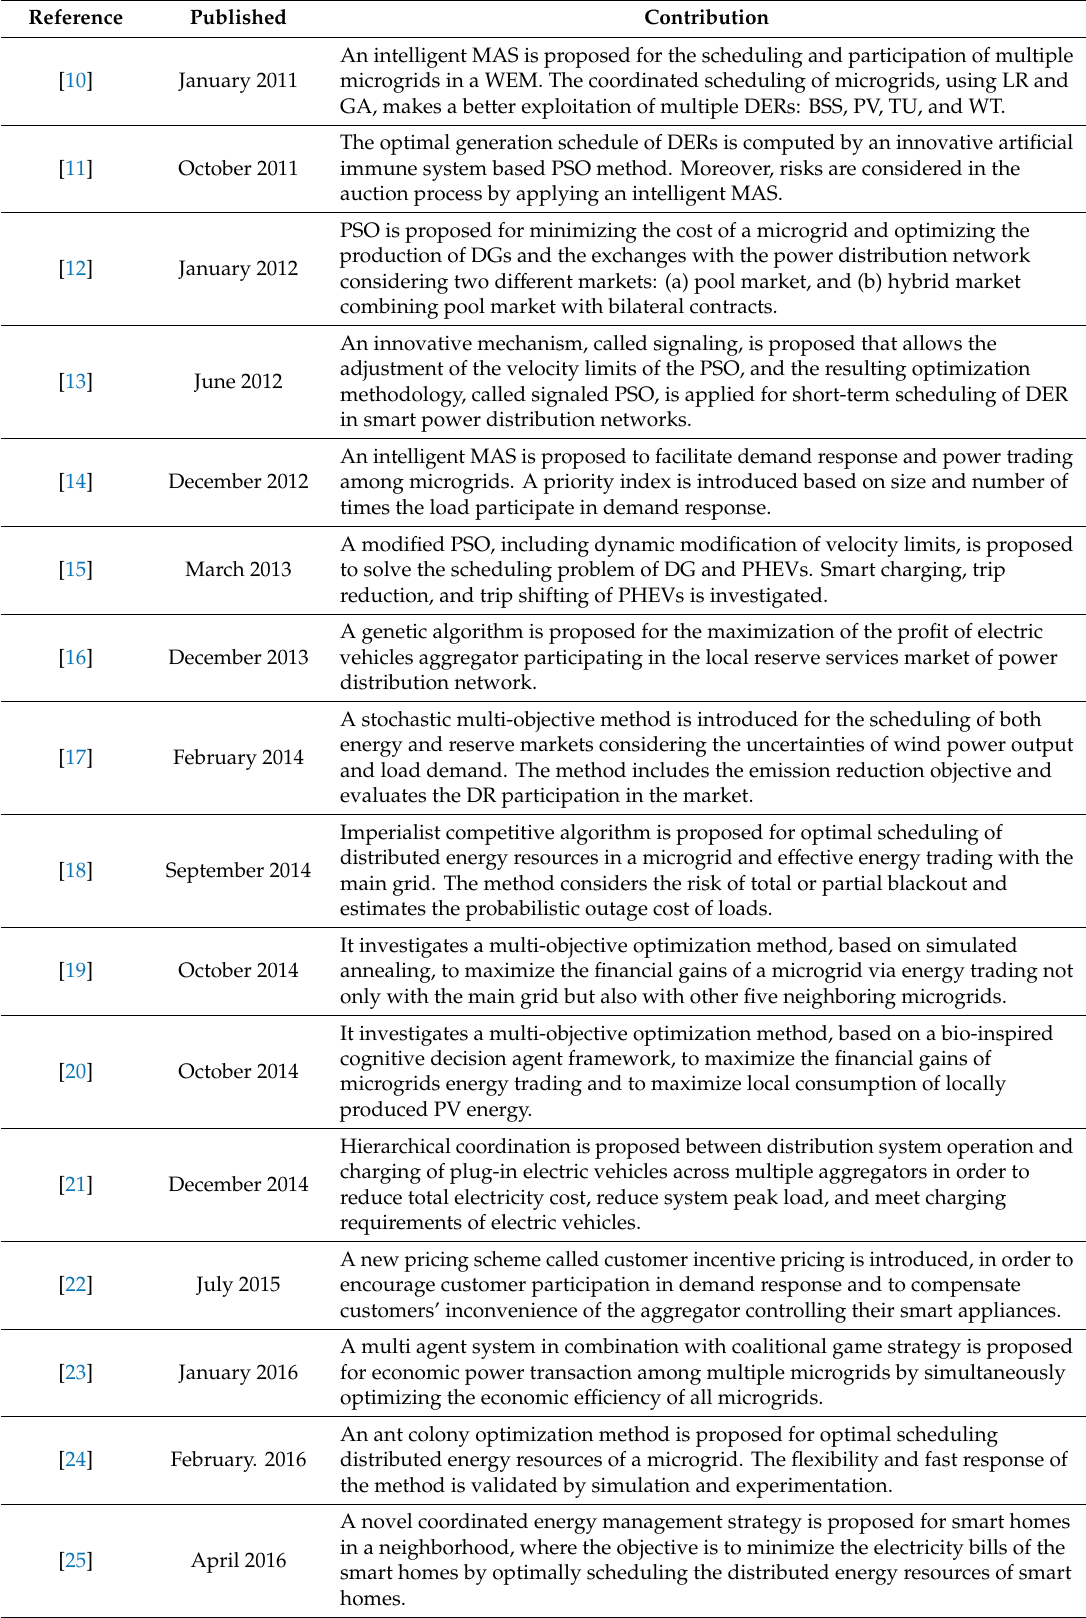
Table 4. Contribution of the reviewed